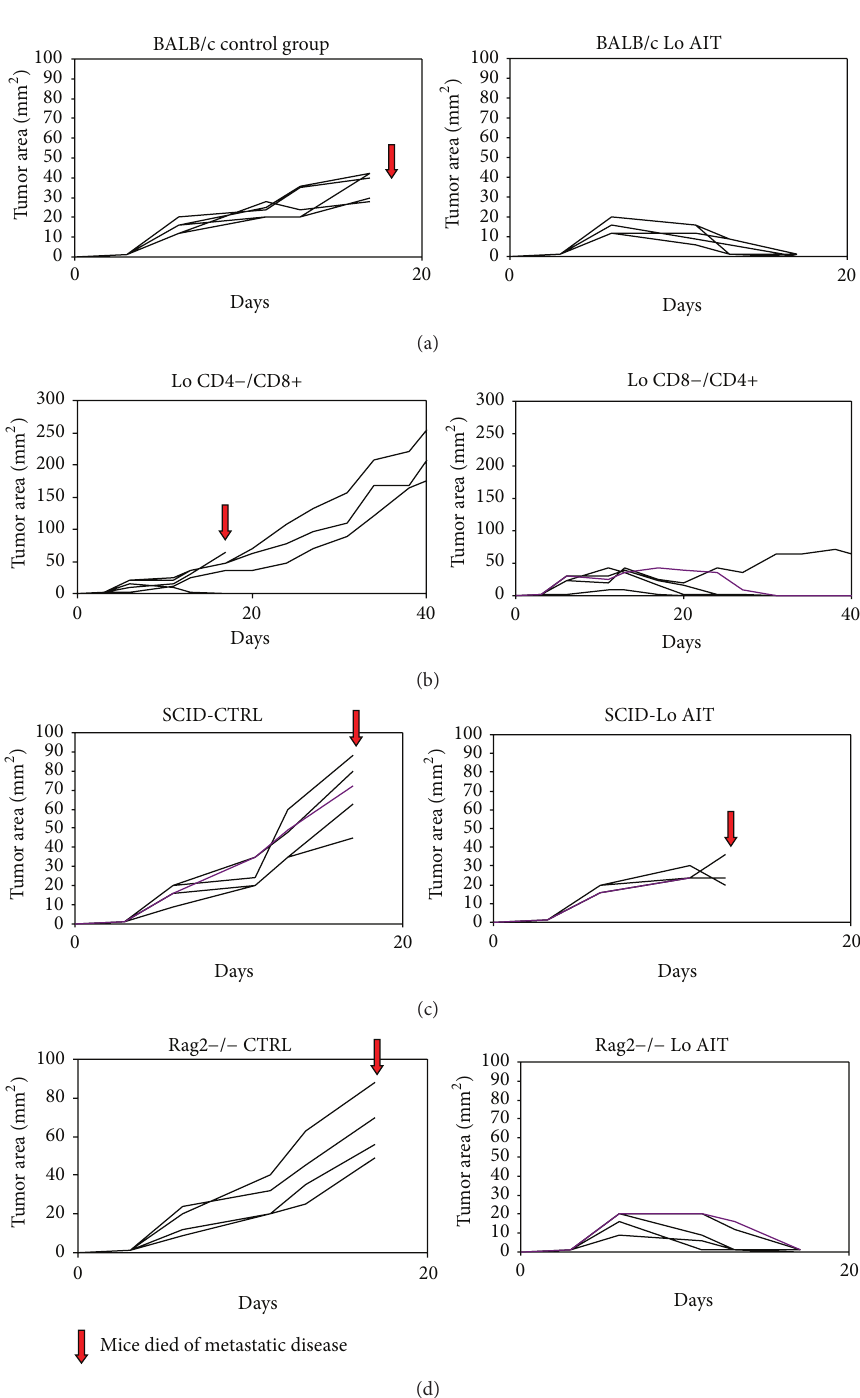
Figure 3: (a) 4T1 TDLNs transferred into BALB/c mice. BALB/c mice bearing 3-day established 4T1 subcutaneous tumors treated with 4T1 TDLNs (Lo AIT) were cured of tumor while those treated with HBSS (control) died of metastatic disease. Each line represents one mouse ( 𝑛 = 5 ). (b) CD4/CD8 depleted TDLNs into BALB/c mice. BALB/c mice with 4T1 subcutaneous tumors were treated with 4T1 TDLNs depleted of CD4 or CD8 cells. Therapeutic efficacy of transferred TDLN appears to be primarily related to intact CD4. Each line represents one mouse ( 𝑛 = 5 ). (c) 4T1 TDLNs transferred into SCID mice. SCID mice bearing 3-day established 4T1 subcutaneous tumors treated with 4T1 TDLNs and control mice all died, suggesting the need for some immune competence in the tumor-bearing mice for tumorigenicity of transferred TDLNs. Each line represents one mouse ( 𝑛 = 5 ). (d) 4T1 TDLNs transferred into Rag2 − / − mice. Rag2 − / − mice bearing 3-day established 4T1 subcutaneous tumors were treated with HBSS (CTRL, 𝑛 = 4 ) or 4T1 TDLNs (Lo AIT, 𝑛 = 5 ). Results suggest that NK cells within the tumor-bearing host are necessary for therapeutic activity of transferred TDLN. Each line represents one